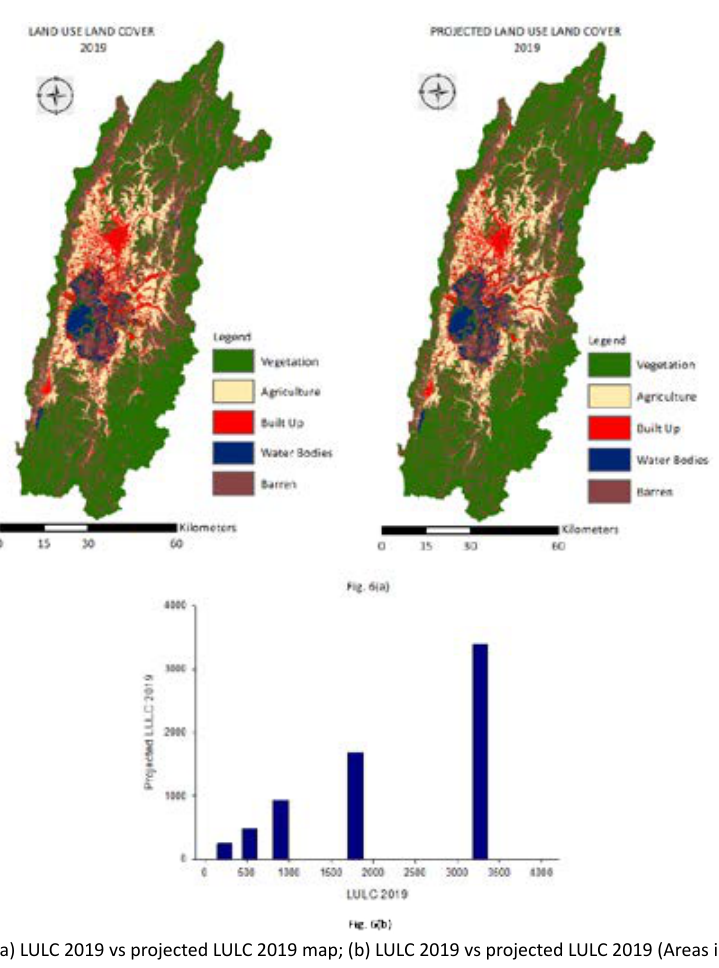
Fig. 6: (a) LULC 2019 vs projected LULC 2019 map; (b) LULC 2019 vs projected LULC 2019 (Areas in km 2 )